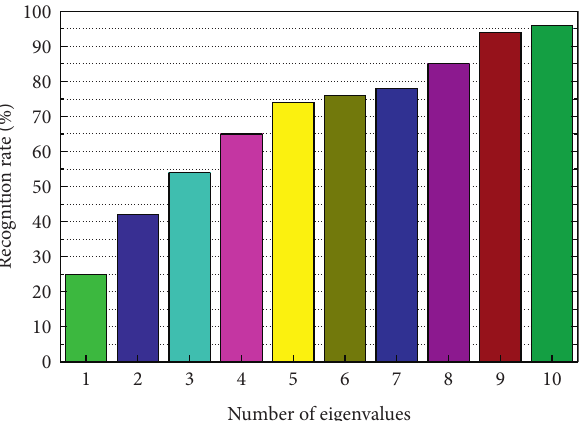
Figure 5: Relationship between the number of features and the recognition rate.